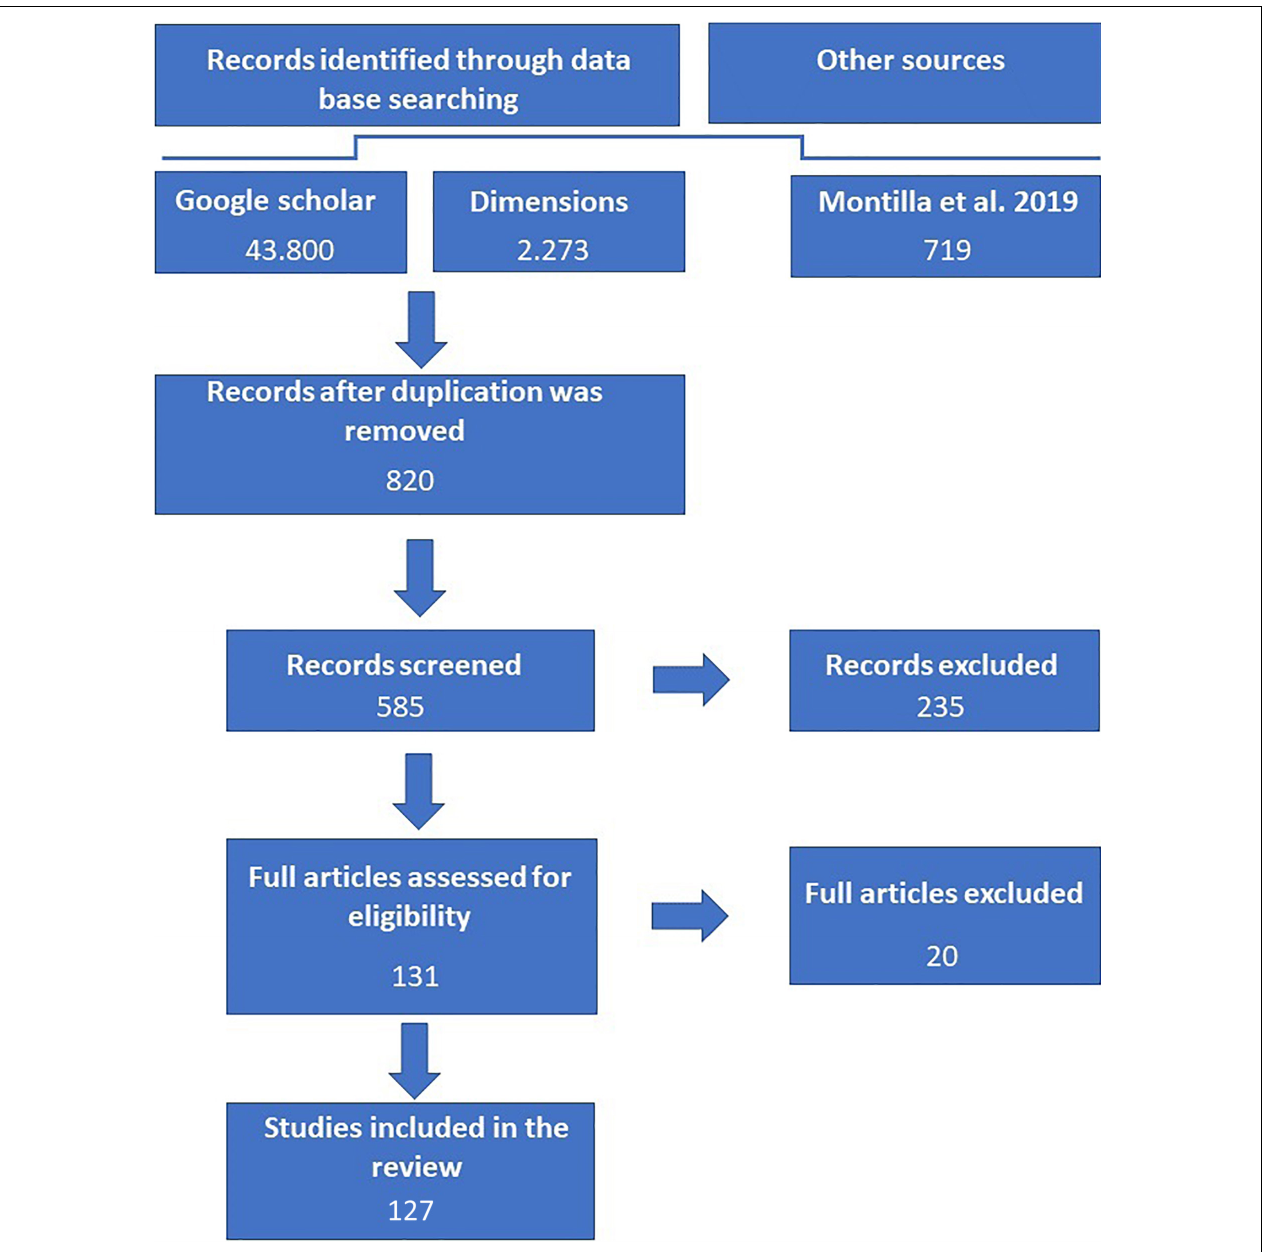
FIGURE 1 | Prisma diagram showing the workflow conducted for the literature review. Three data bases were consulted. In addition, local and regional monitoring data bases (e.g., AGRRA) were consulted for reports and news (not displayed in the